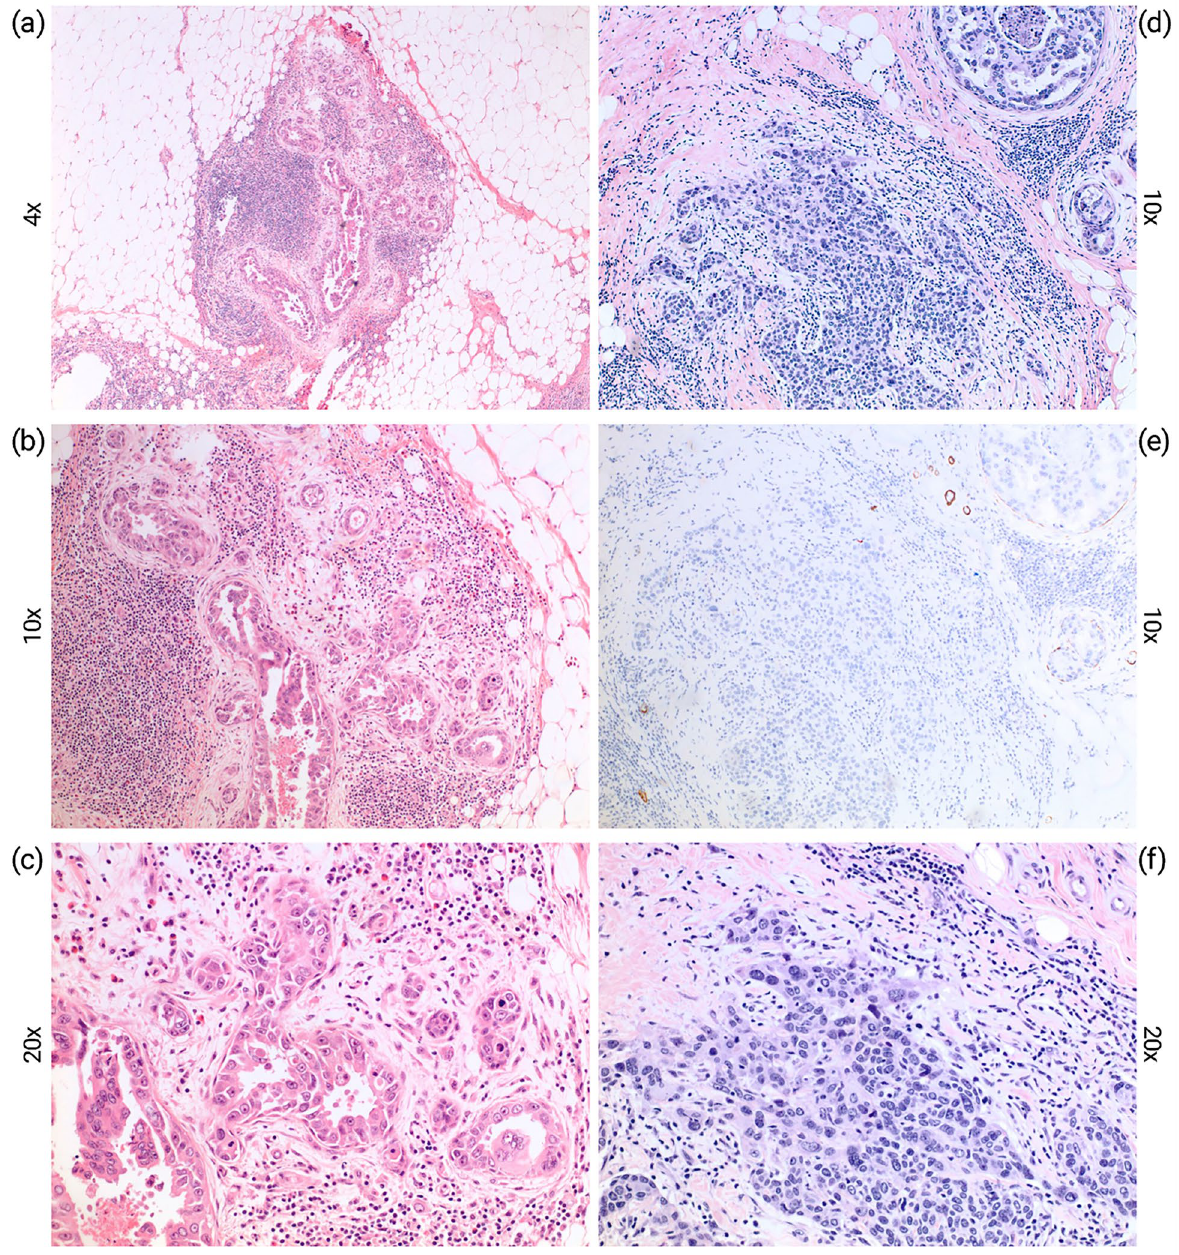
nuclear grade with comedo necrosis; ( d – f ) microinvasive carcinoma (0.8 mm) arising in ductal carcinoma in situ (DCIS), solid and cribriform patterns, with comedonecrosis and associated microcalcifications. The invasive component is negative for smooth muscle myosin heavy change by immunostaining ( e